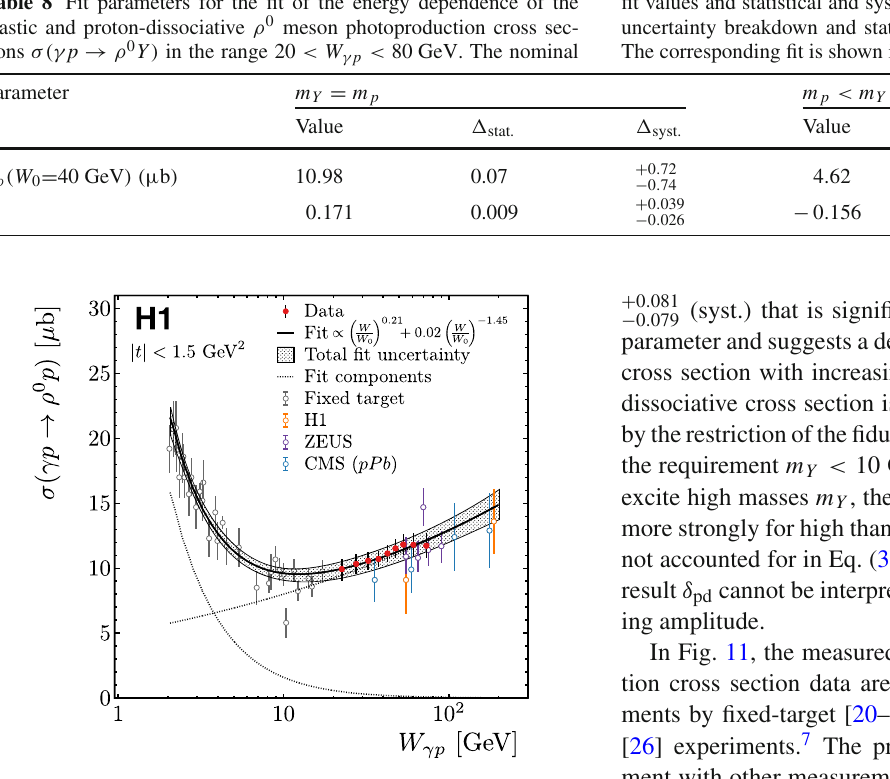
Table 8 Fit parameters for the fit of the energy dependence of the elastic and proton-dissociative ρ 0 meson photoproduction cross sec-